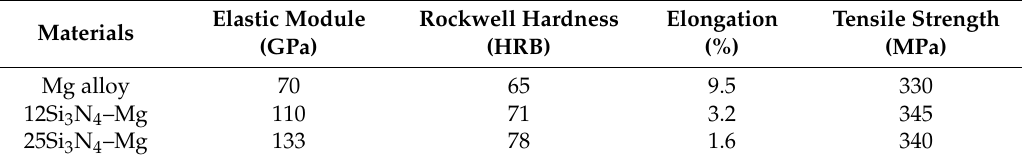
Figure 1. SEM micrographs image and technical diagram: ( a ) Si 3 N 4 reticulated ceramic skeleton; ( b ) Si 3 N 4 –Mg composite; ( c ) the schematic diagram of infiltration equipment. Table 1. The mechanical properties of Mg alloy and Si 3 N 4 –Mg composite.